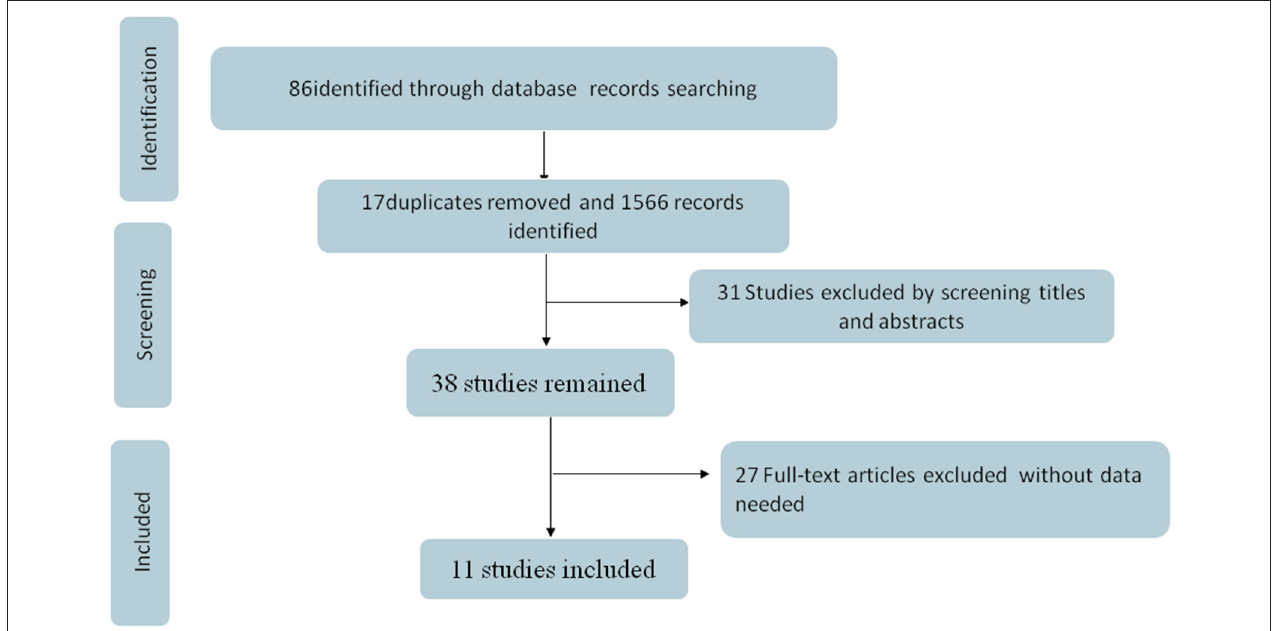
FIGURE 1 | Flowchart presenting the steps of the literature search and